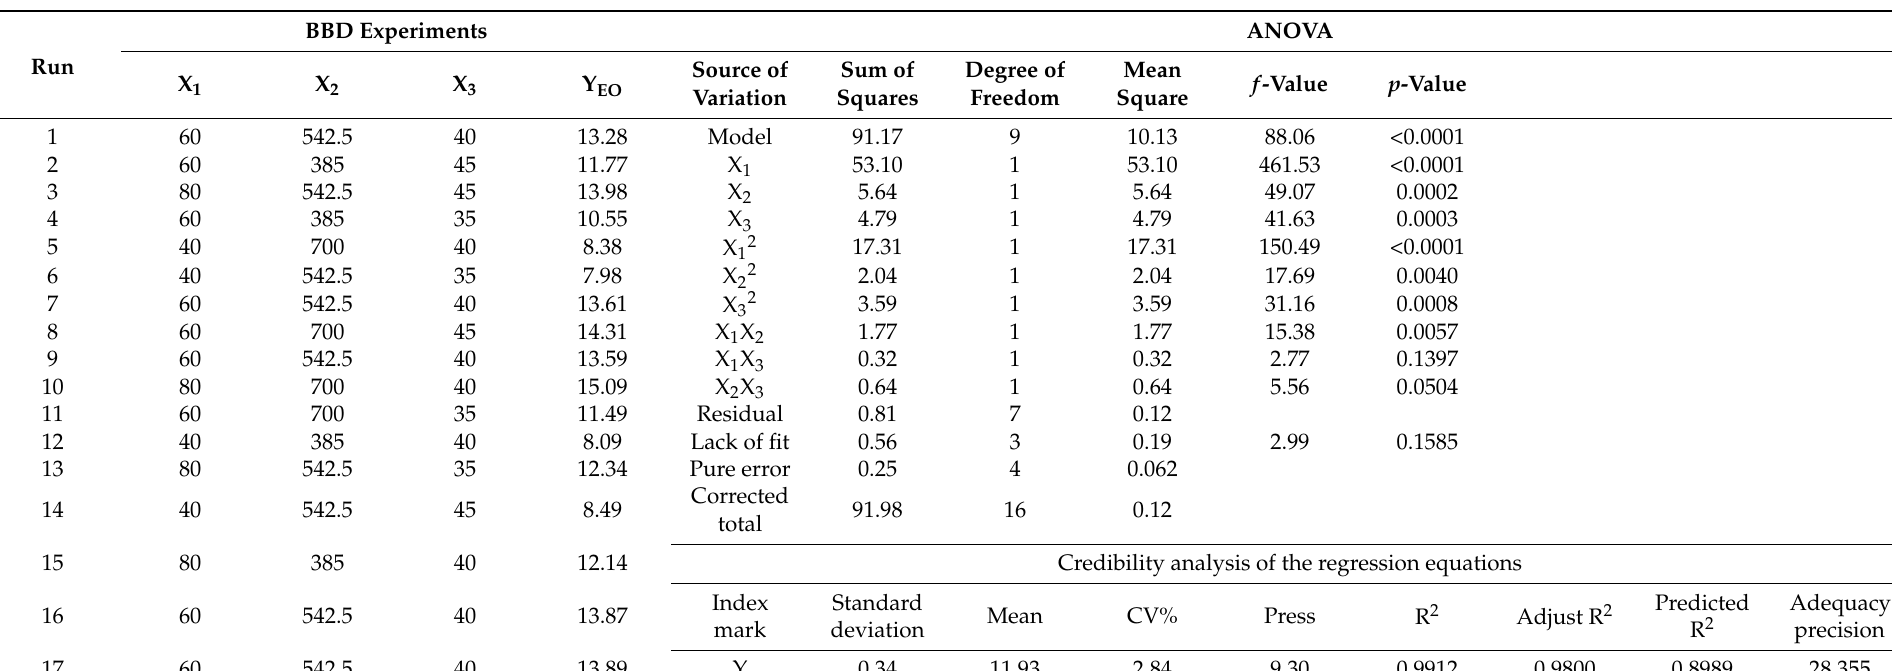
Table 2. Box-Behnken design (BBD) with experimental value for a total yield of EO (mL/kg DW), analysis of variance (ANOVA) for response surface quadratic model, and fit statistics for response